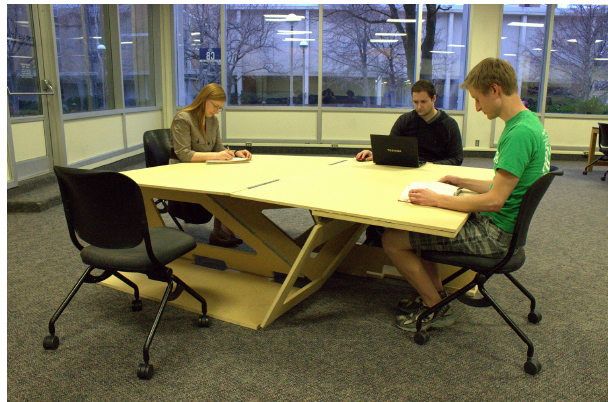
Figure 13. This origami-based table supports a significant amount of weight. Unlike the other examples in this paper, the table is de- signed to unfold to an intermediate position that does not corre- spond to the zero-thickness model’s fully unfolded position. The panels in this design are 0.75